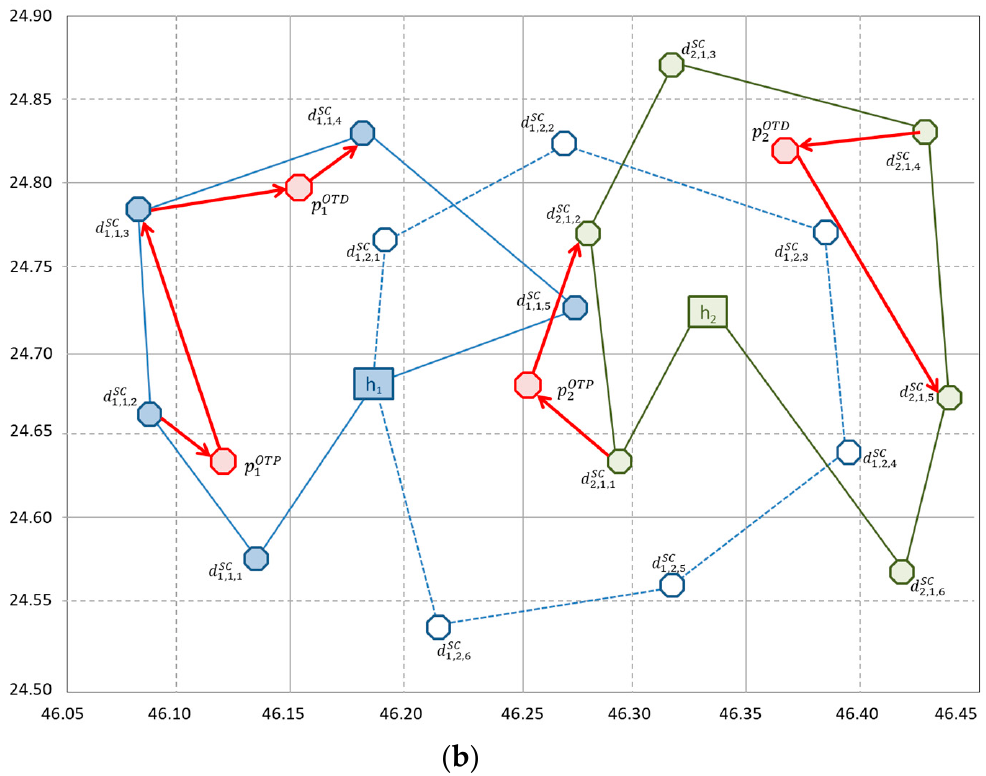
Figure 16. Scheduled routes without and with constrained time frame in Scenario 5: ( a ) The open tasks are assigned to the scheduled routes real-time, time frame constraints are not taken into consideration; ( b ) The open tasks are assigned to the scheduled routes real-time with time frame constraints.